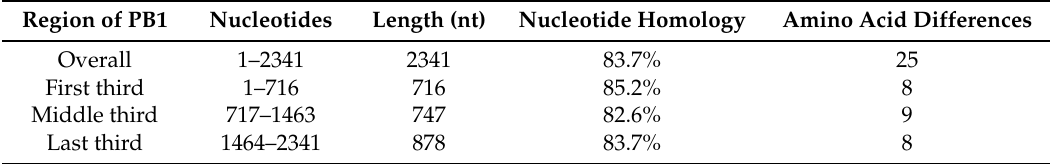
Figure 1. Structure of chimeric PB1 plasmids and functional domains of the PB1 gene. ( A ) Schematic representation of chimeric PB1 plasmid constructs. The origin of each third of the gene is colour ‐ coded, orange represents PR8 (P) and blue represents Udorn (U) sequences. The nucleotide length and boundaries of each section are indicated. Influenza vRNA are numbered from 3 ′ to 5 ′ according to international nomenclature; ( B ) Schematic representation of the functional domains of the PB1 protein highlighting the amino acid differences between Udorn and PR8 PB1. Polymerase acidic protein (PA) binding domain (yellow); Nuclear localization signals (N); conserved RNA ‐ dependent RNA polymerase motifs (red); Polymerase basic protein 2 (PB2) binding domain (blue); interaction with viral RNA (vRNA) and complementary RNA (cRNA) (orange). Amino acid differences between PR8 and Udorn PB1 proteins are shown below the schematic with smaller grey lines indicating the location of conservative amino acid changes and bigger red lines indicating non ‐ conservative amino acid changes. Table 1. Nucleotide homologies and amino acid differences between Udorn PB1 and PR8 PB1. Region of PB1 Nucleotides Length (nt) Nucleotide Homology Amino Acid